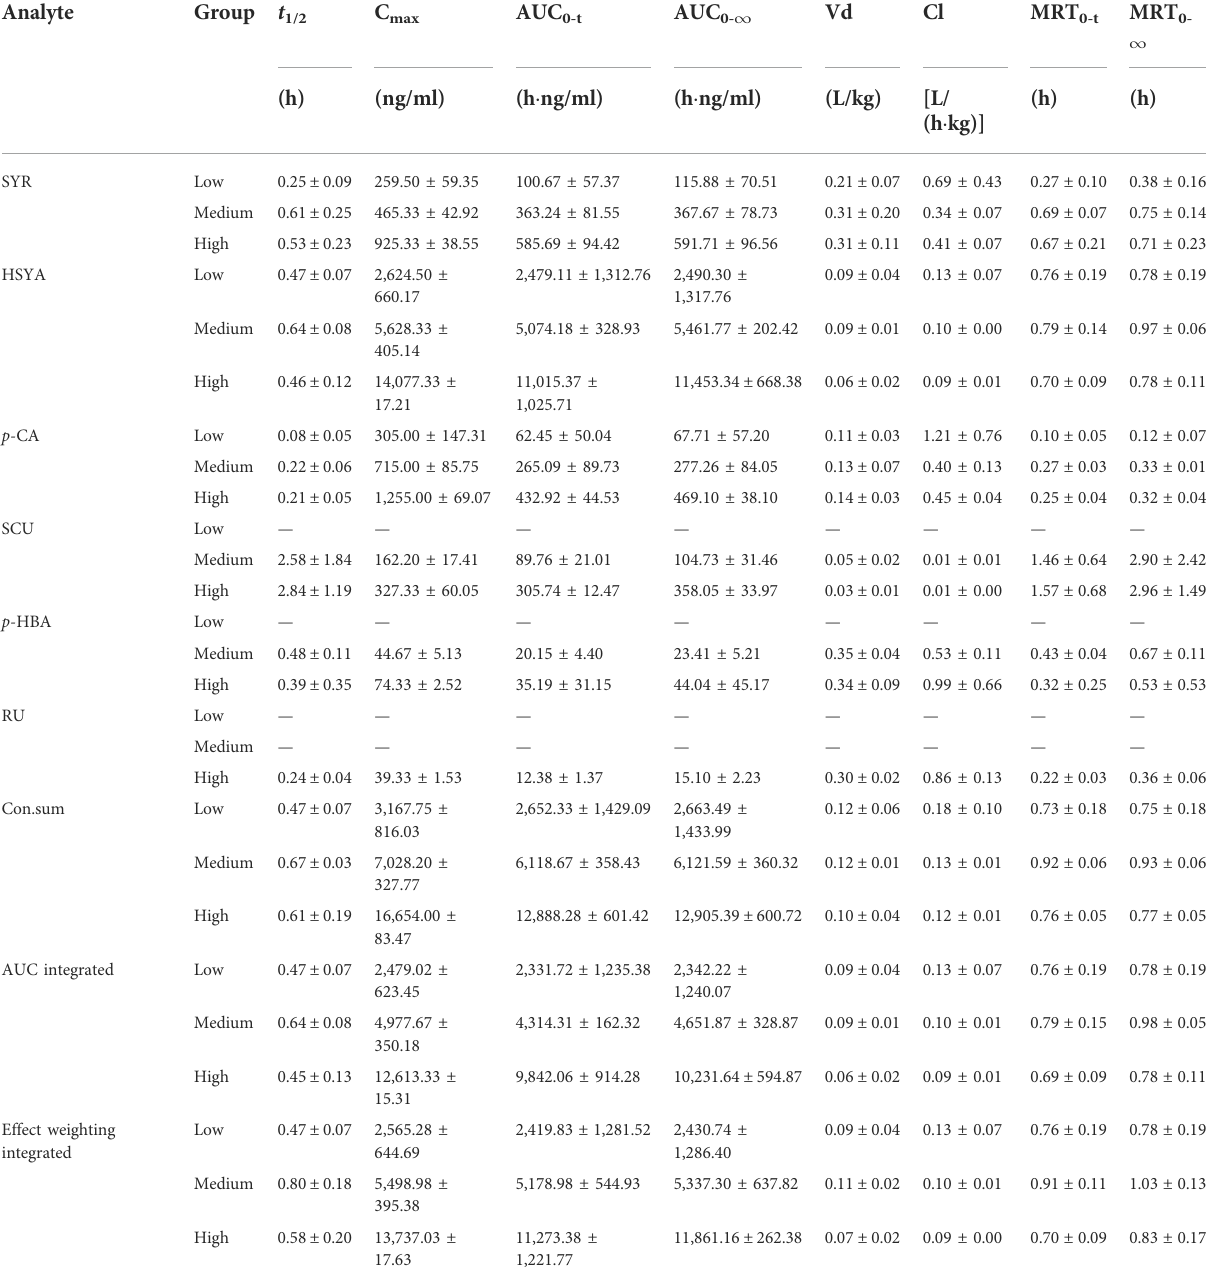
TABLE 1 The PK parameters of six ingredients in rat plasma after i.v. , administration of SI with low and high dosages (Mean ± SD).